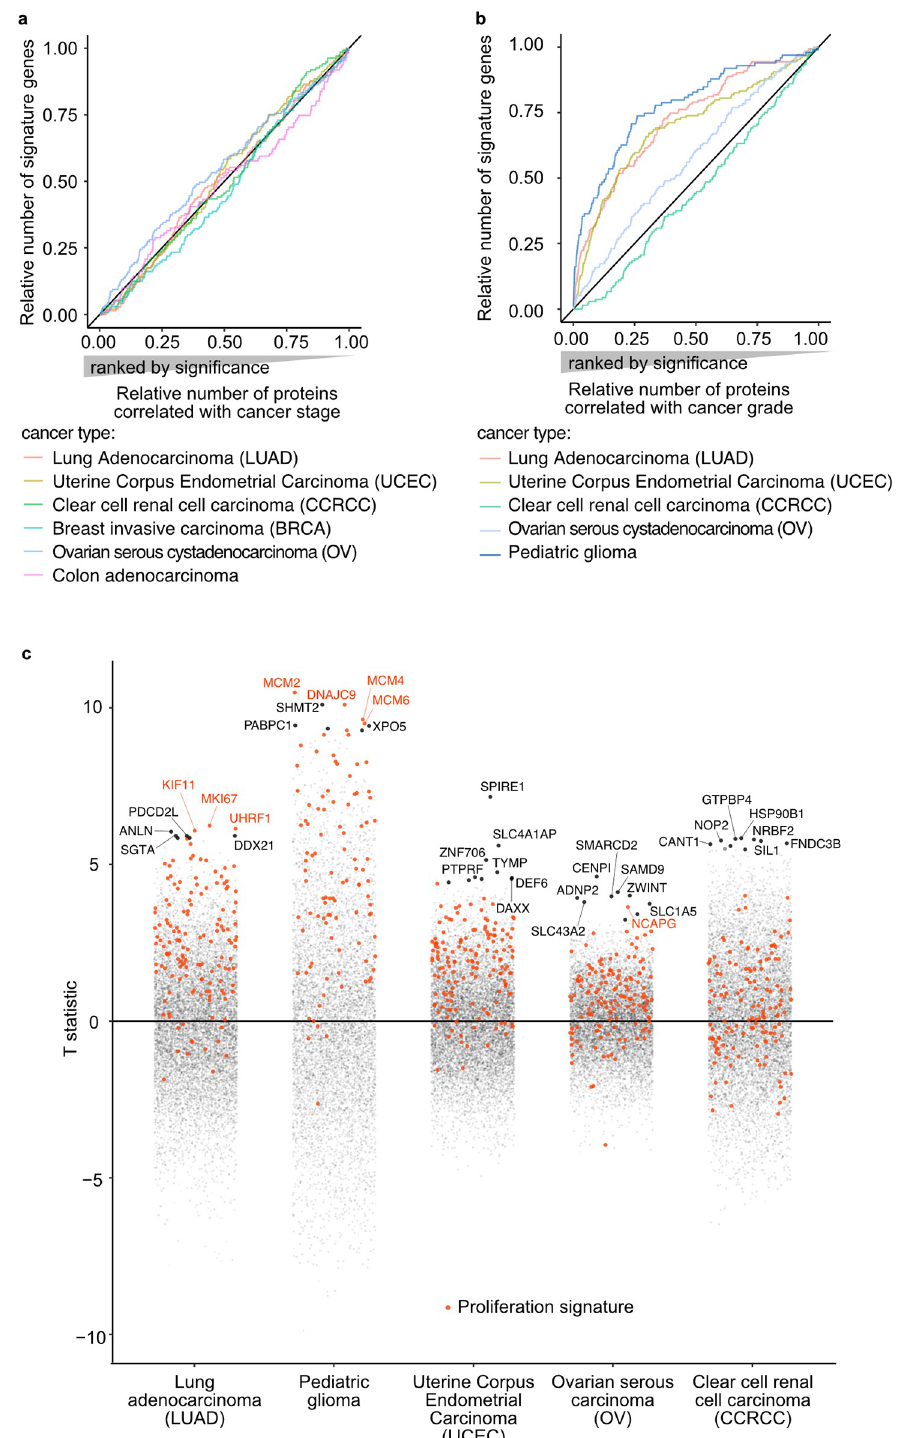
Fig 5. Proliferation signature in the context of cancer grade. a-b) Enrichment of the proliferation signature in proteins associated with cancer stage (a) and grade (b). Proteins were ranked by significance of correlation according to Monsivais et al . [6] ( p -value of Pearson correlation) (horizontal axis) and the vertical axis presents the cumulative number of signature genes for each cancer type. d) Proteins T-statistic provided by Monsivais et al . [6] for the analysis of cancer grades (positive = high correlation with cancer grade) for each cancer type (horizontal axis). Each